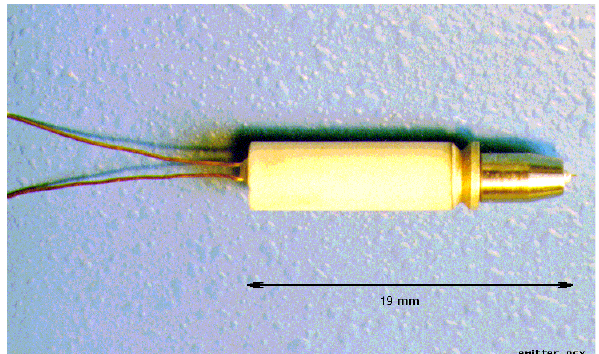
Fig. 3. Photograph of an indium ion emitter. The reservoir at the right is heated by the heater element at the left. The total length is